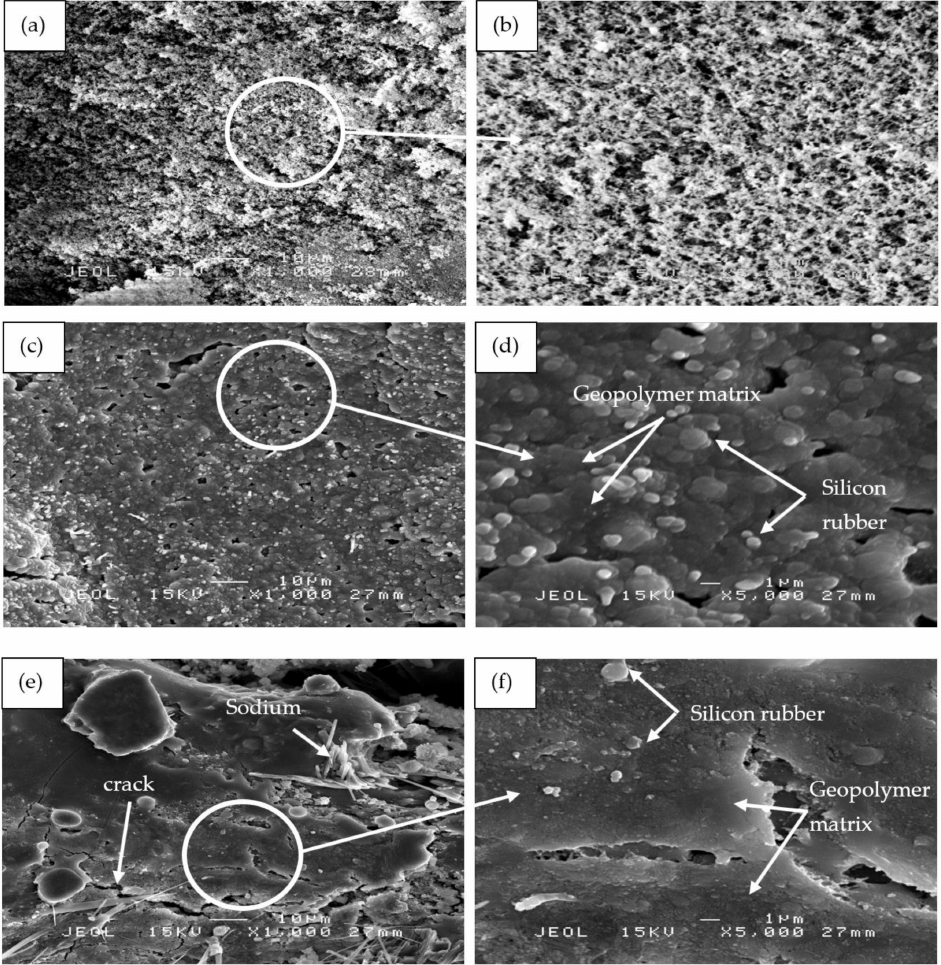
Figure 12. SEM micrographs of RHA/SiR-based binary blended geopolymer coating composite of the residues obtained from fire retardant tests with ( a , b ) good (sample S17), ( c , d ) moderate (sample S18), and ( e , f ) poor fire retardant properties (sample S21) at 1000 × and 5000 ×